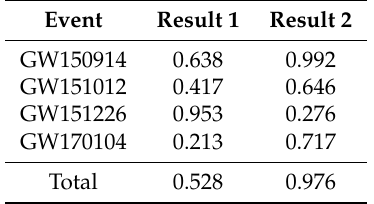
Table 19. p -value for each event and total p -value [19]. Result 1 is the case when the phase shift is fixed to π , and result 2 is the case when the total phase shift is also a